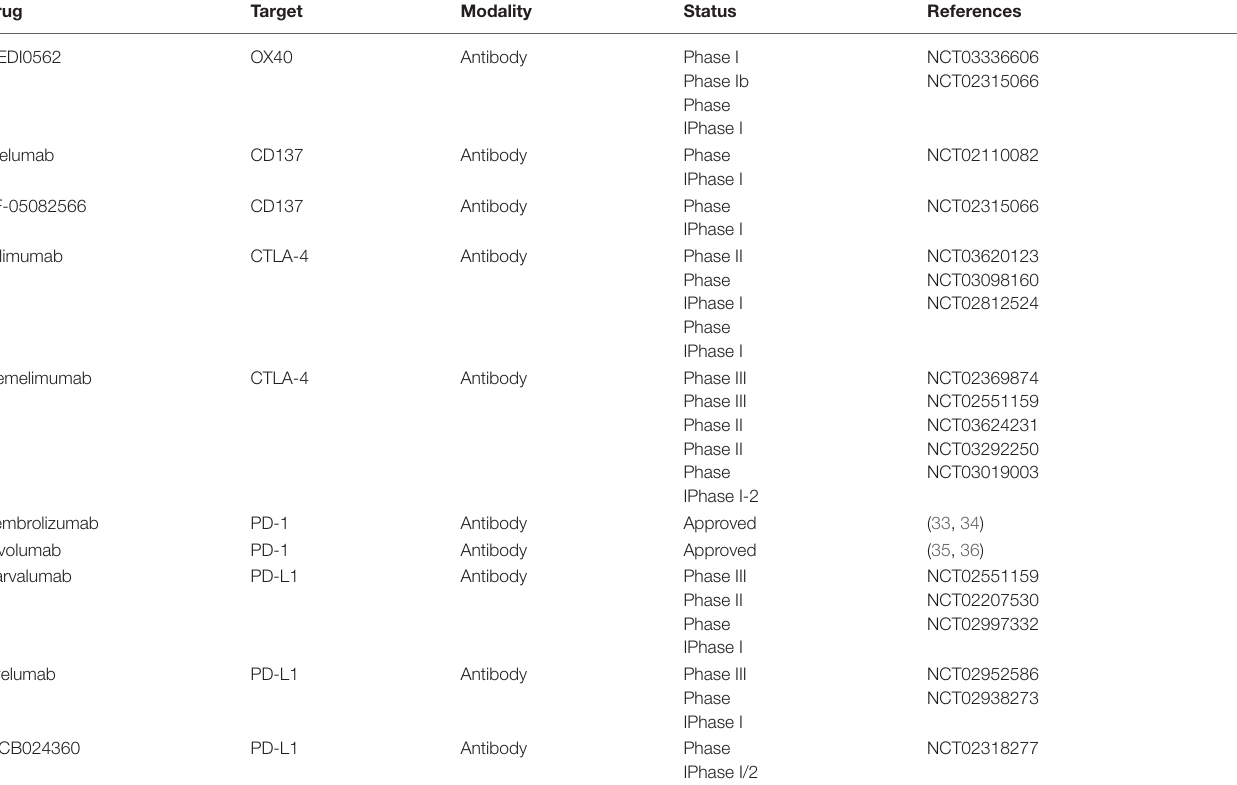
TABLE 1 | Immunological targeted therapies approved or under investigation for the treatment of head and neck cancers.